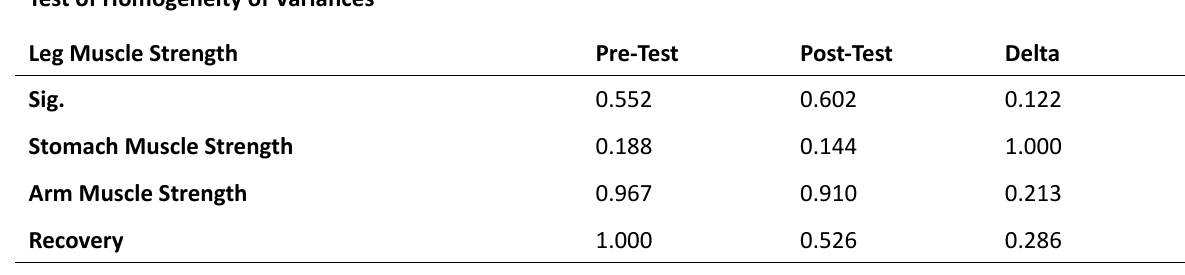
Table 2. The Result of Homogenity Test Test of Homogeneity of Variances